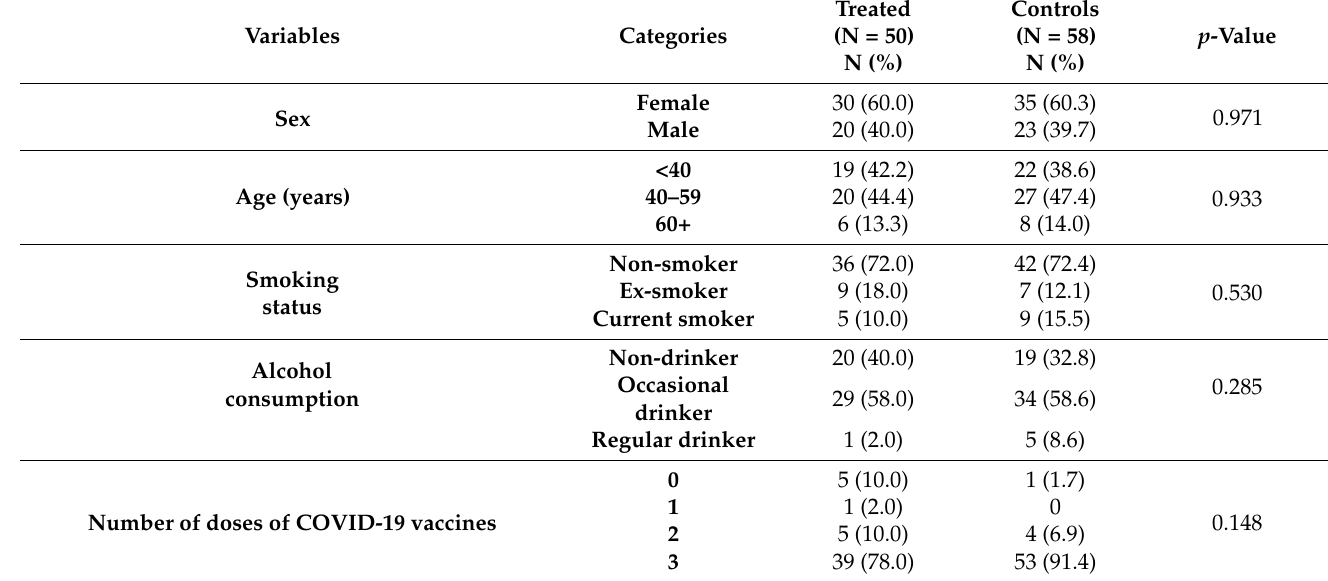
Table 2. Main characteristics of study participants, by treatment and control group. Number (N), column percentage (%) and p -value (chi-square